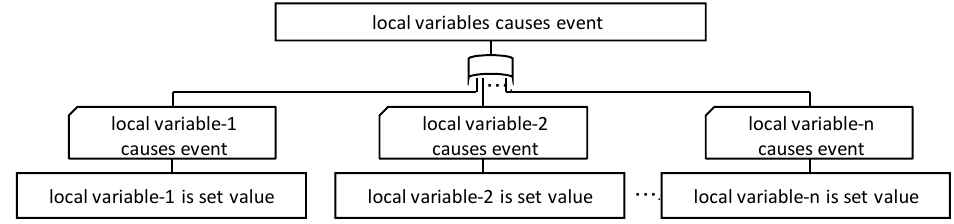
Figure 10. FTT for local variables.